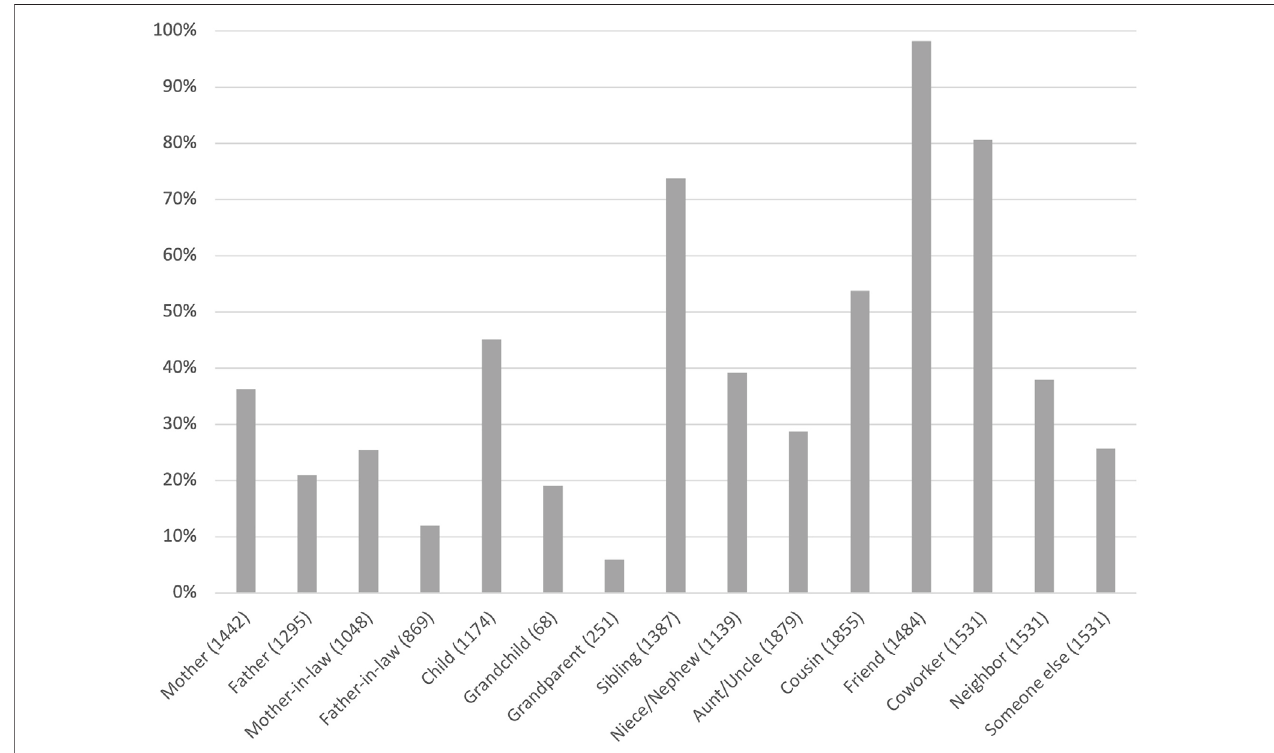
FIGURE 2 | Percentage of respondents in the younger generation (aged 19 – 56) connected with kin and non-kin via social media. In the case of relatives, ( n ) indicates the number of respondents with the given relative.